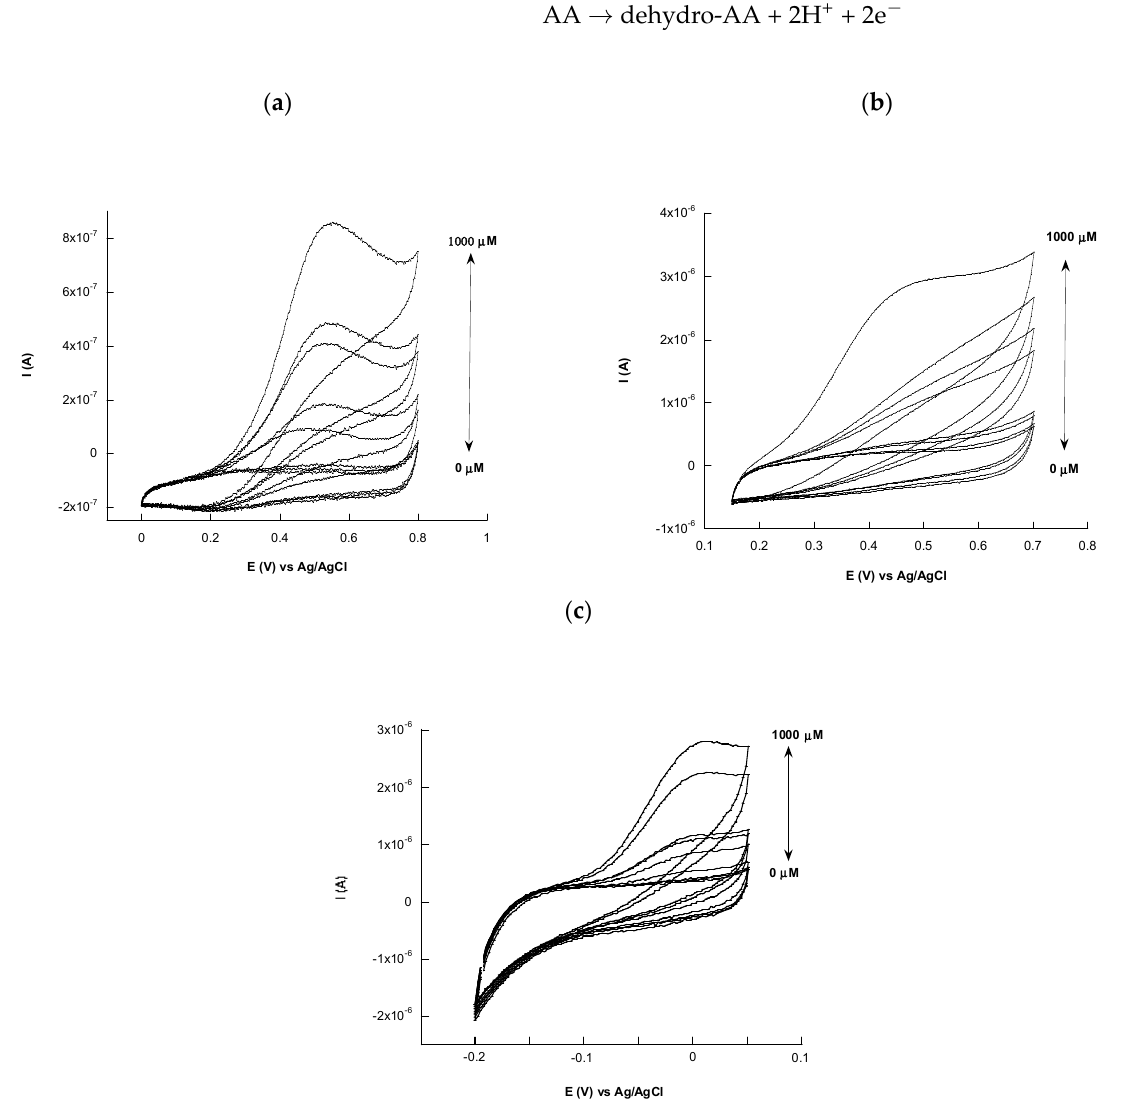
Figure 7. CVs of Au bare ( a ), Au/SWCNTs ( b ) and h-nPG ( c ) electrodes in 0.1 M PBS buffer (pH 7.4), 0.1 M KCl in absence and in presence of different concentrations of AA (0; 10; 25; 150; 200; 400; 800; 1000 M), at υ = 10 mV s − 1 .